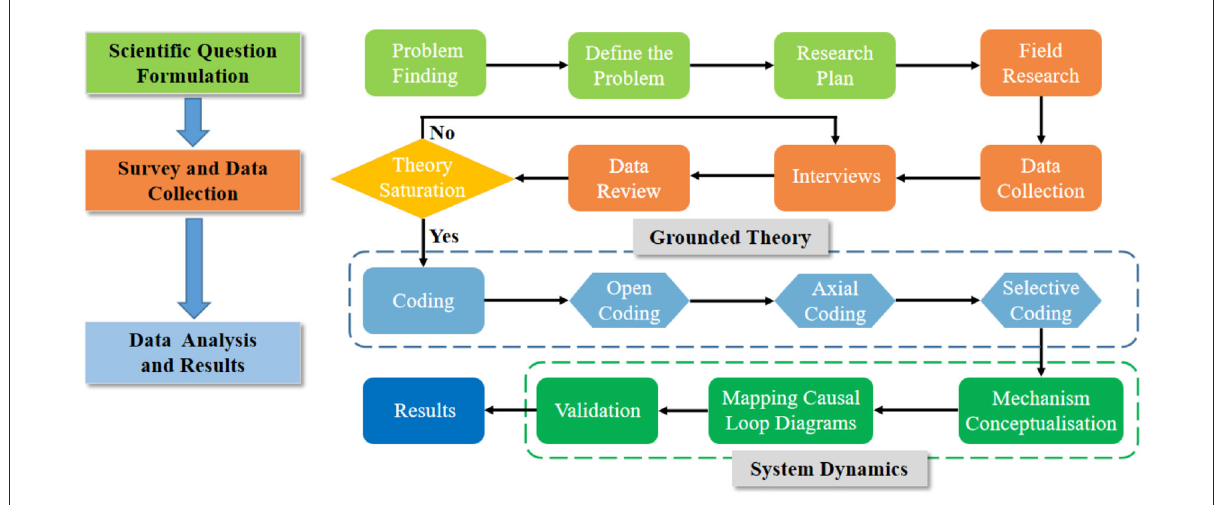
FIGURE2 Research methodology process of qualitative system dynamics